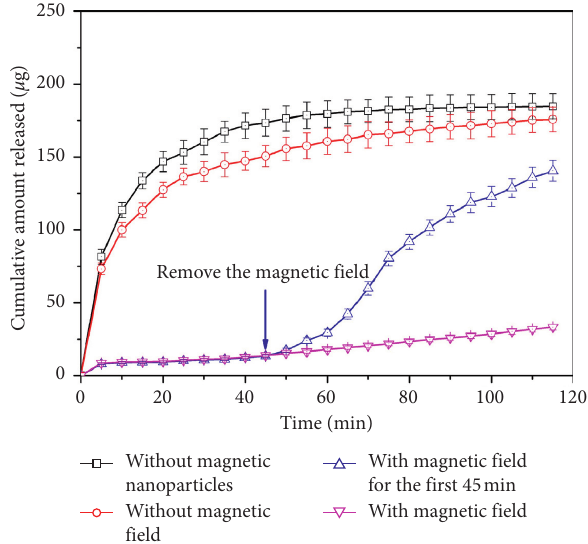
Figure 5: Cumulative released profile of drug molecules with and without trigger of a static magnetic